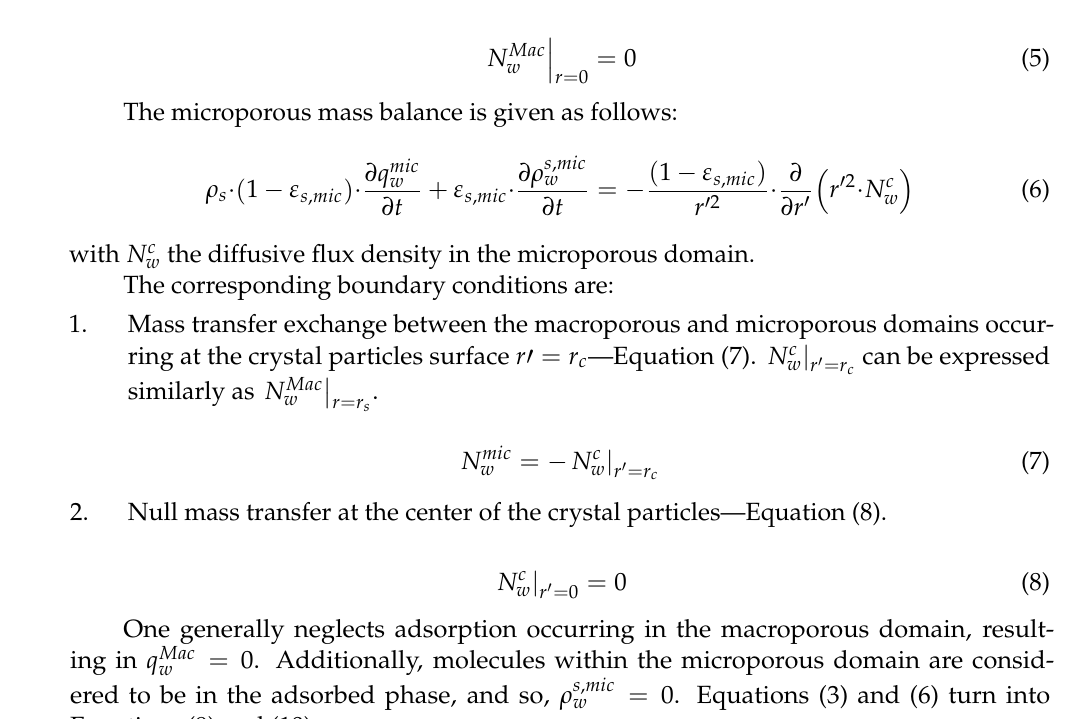
2. Null mass transfer at the center of the crystal particles—Equation (8).